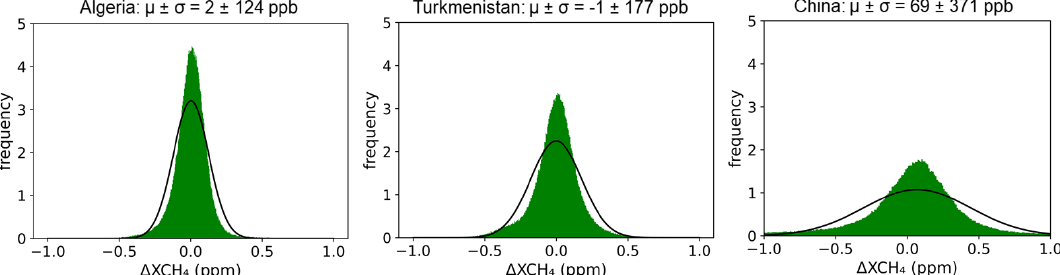
Figure 8. Histograms of the resulting 600 × 600 (cid:49) XCH 4 subset areas using three original WV-3 images with a different type of surface. The mean and standard deviation values of the distributions for each site are shown in the chart